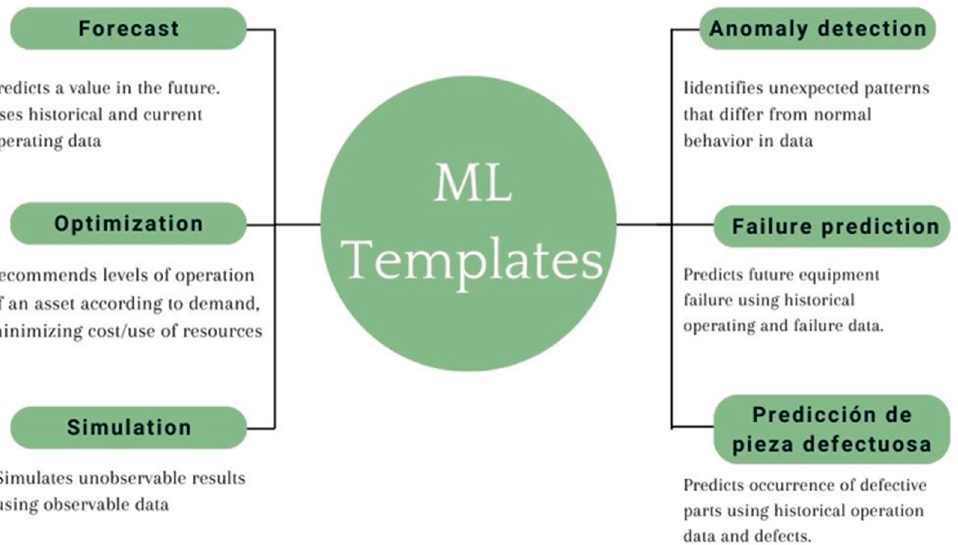
Figure 1. Schema of the six preconfigured templates the LCP offer, and the scope of each one. Source: authors.